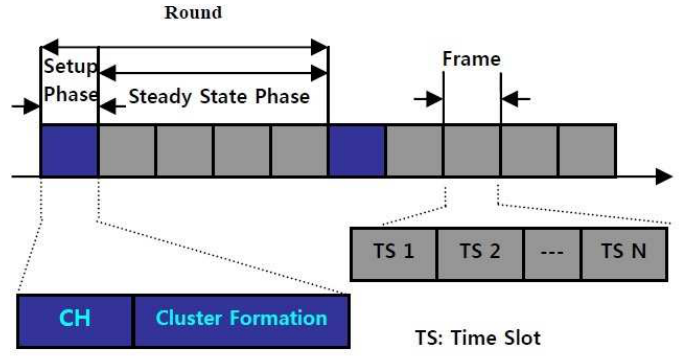
Figure 2. LEACH frame